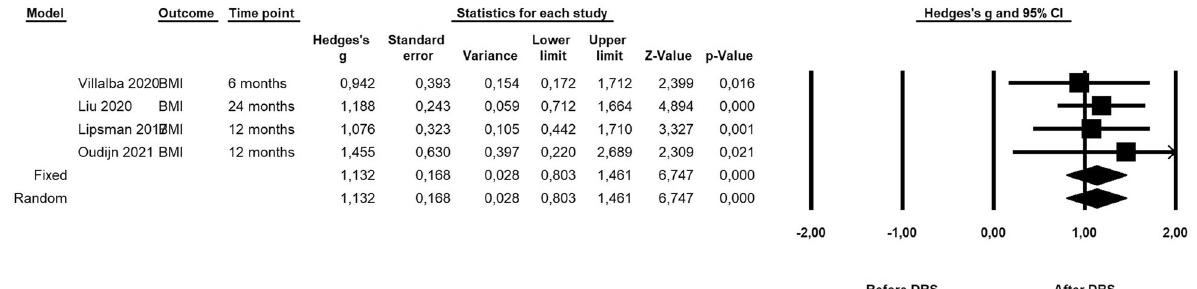
Fig. 2 Forrest plot showing meta-analysis effects of DBS on primary outcome BMI.